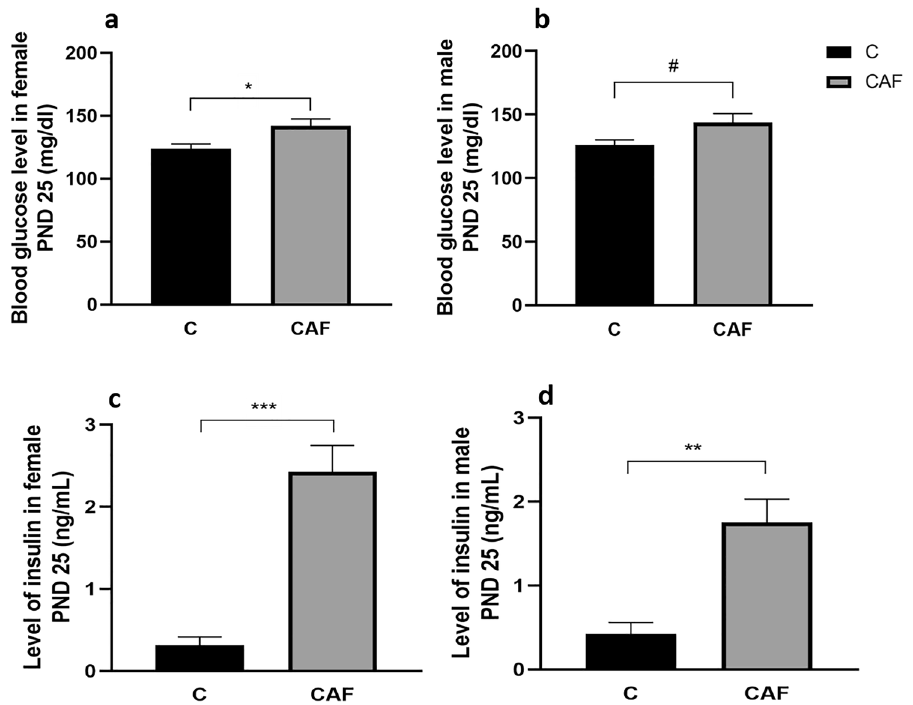
Figure 5. Metabolic status in offspring on PND 25. ( a ) Blood glucose level in female offspring (*p < 0.05); ( b ) blood glucose level in male offspring ( # p = 0.07); ( c ) blood serum level of insulin in female offspring (***p < 0.005); ( d ) blood serum level of insulin in male offspring (**p < 0.01); C control group, CAF cafeteria group; n =